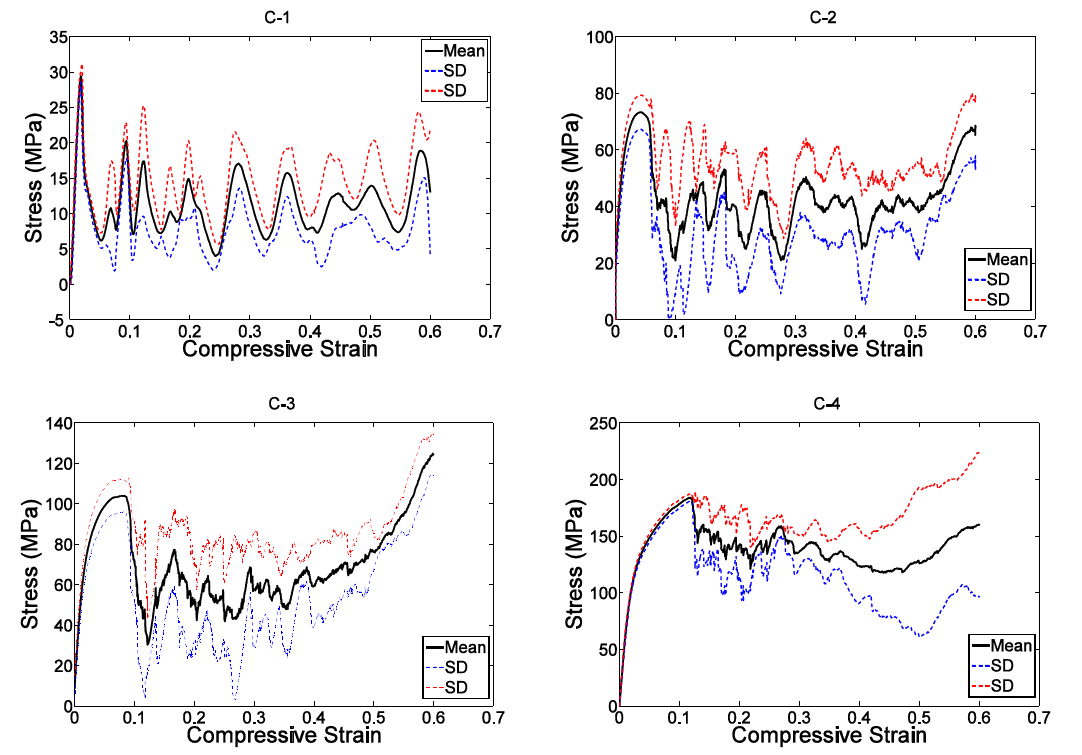
Figure 3. Compressive stress- versus -compressive strain curves for specimens based on the cube unit cell and with different porosities (see Table 2).